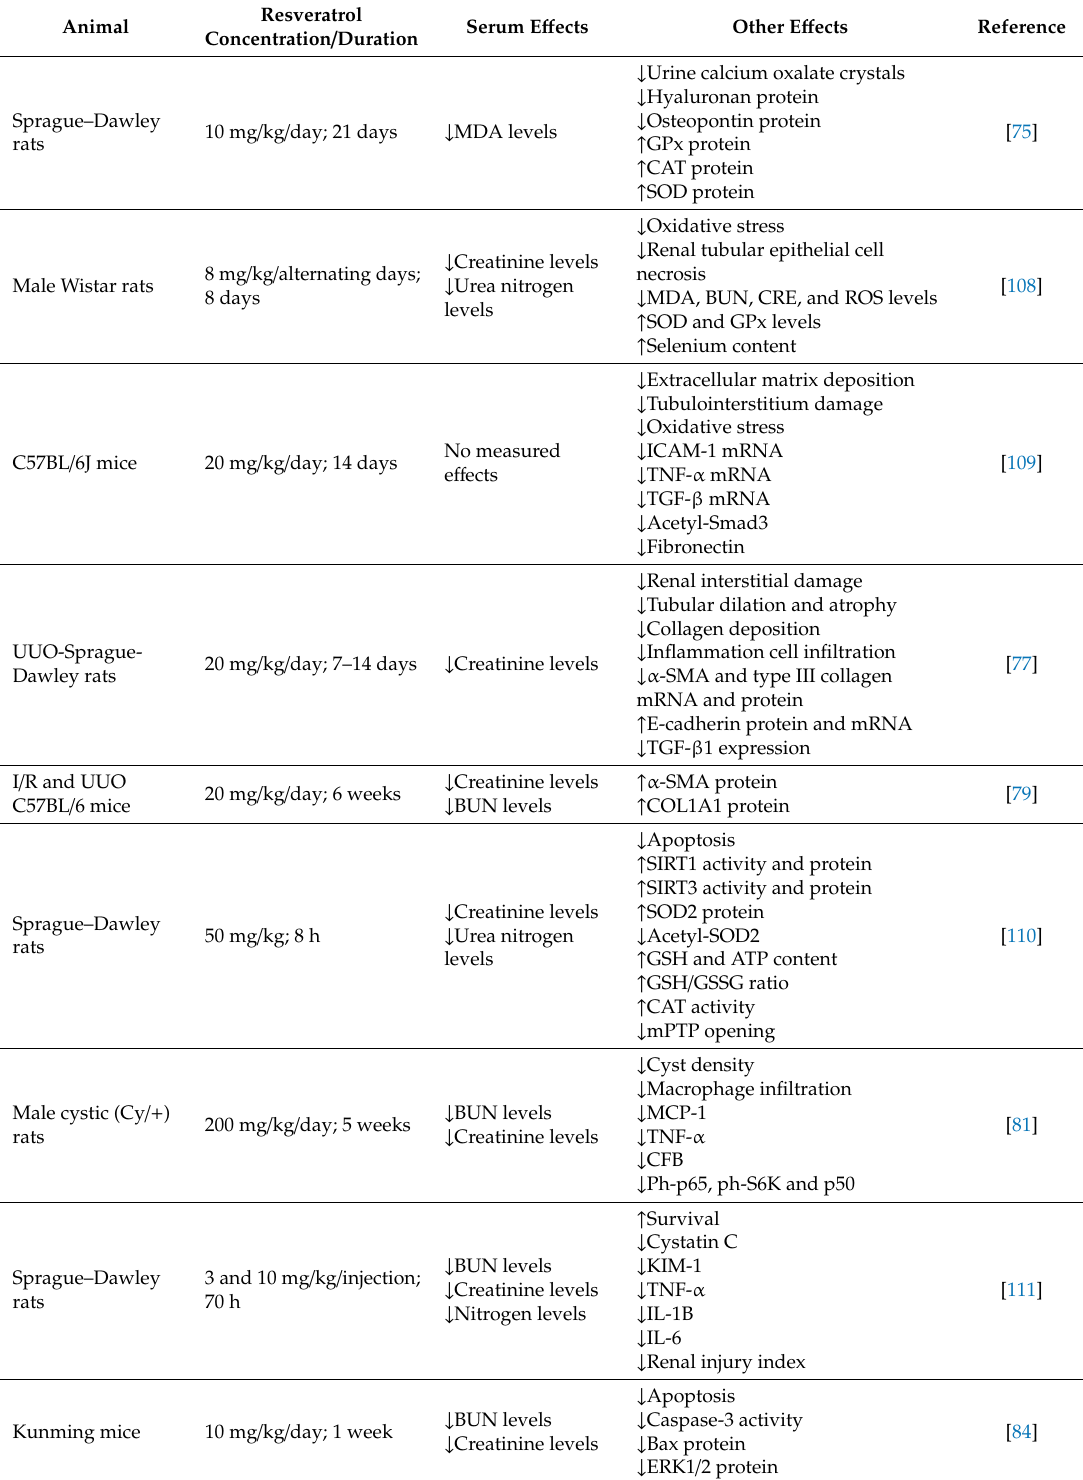
Table 8. E ff ects of resveratrol on renal fibrosis (animal